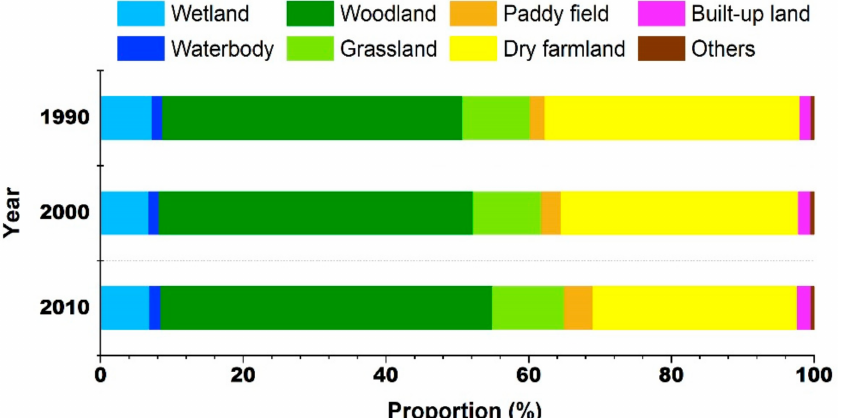
Figure 6. Areal proportions of different land covers in 1990, 2000, and 2010 of the CARB.